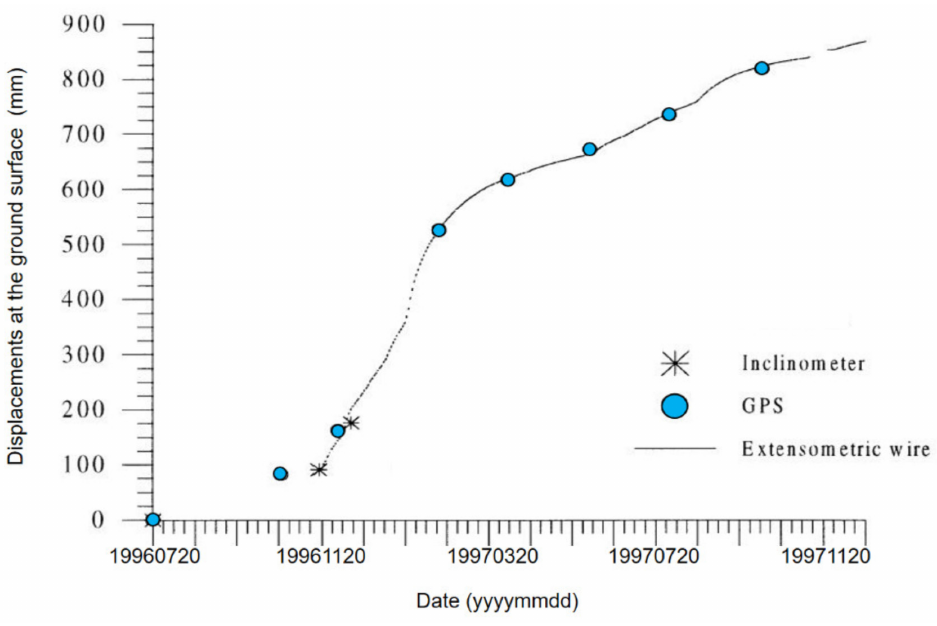
Figure 22. Comparison of the corrected wire extensometer displacement (D h ) against the GPS and the inclinometric measurements of the Vallcebre borehole